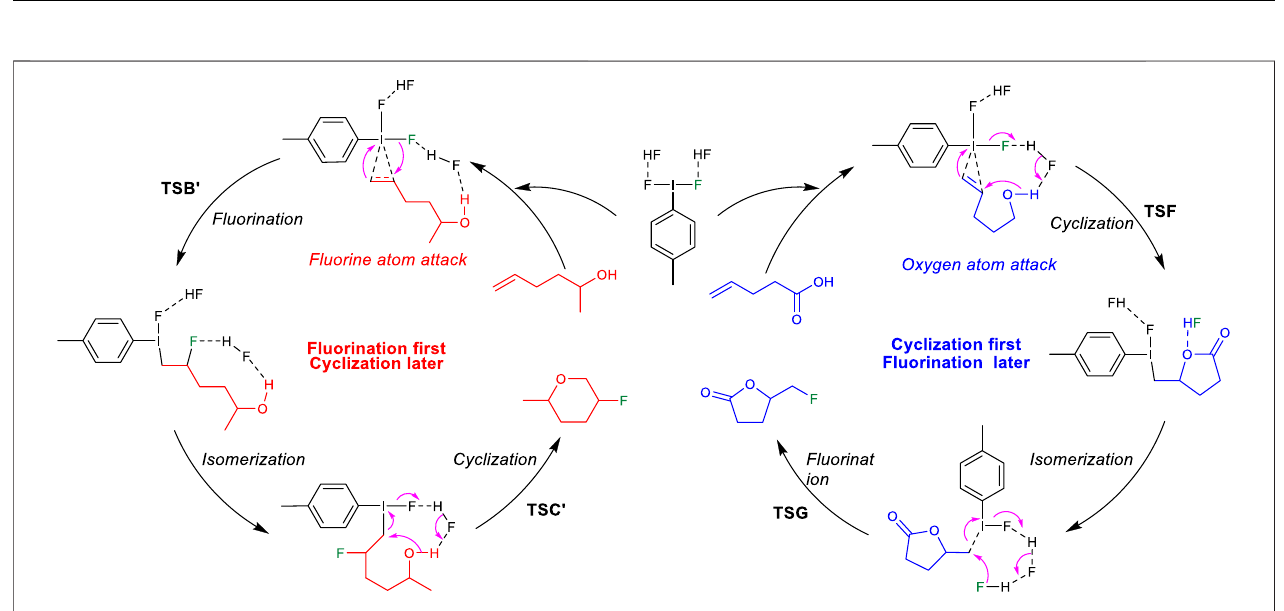
FIGURE4| Free-energypro fi les for the fl uorocyclization ofunsaturated alcohol via the “ cyclization fi rst and fl uorination later ” mechanism. Thepreferred pathway is shown in blue.